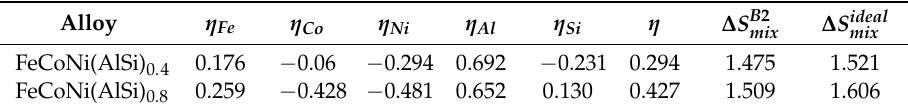
Table 3. The order parameter η i , the mixing entropy for the ideal, taking into account the B2-ordered structure for FeCoNi (AlSi) 0.4 and FeCoNi (AlSi) 0.8 alloys.